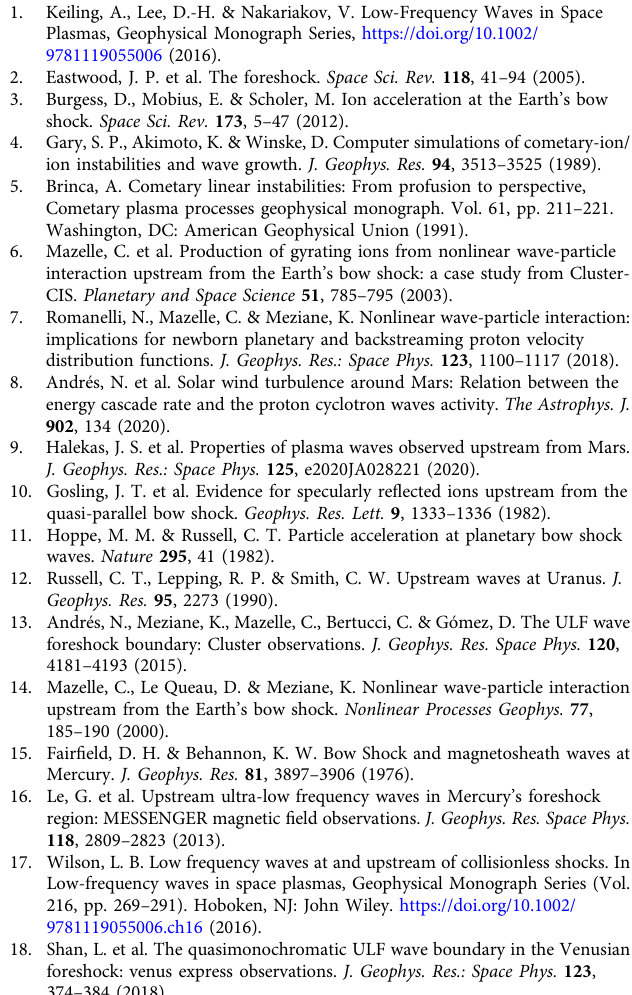
Fig. 7 Lomb-Scargle analysis. Power Spectral Density (Lomb-Scargle analysis) of the wave occurrence rate ( r > 2, λ 23 > 0, shown in Fig. 6b) as a function of frequency. Vertical red dashed line corresponds to Mercury ’ s orbital frequency around the Sun. r is a factor associated with the intensity of magnetic fi eld power spectral density at the wave frequency range of interest, and λ 23 constitutes a threshold for the intermediate to minimum eigenvalue ratio associated with Minimum Variance Analysis. The reader is referred to Eqs. (1) – (3) for a strict de fi